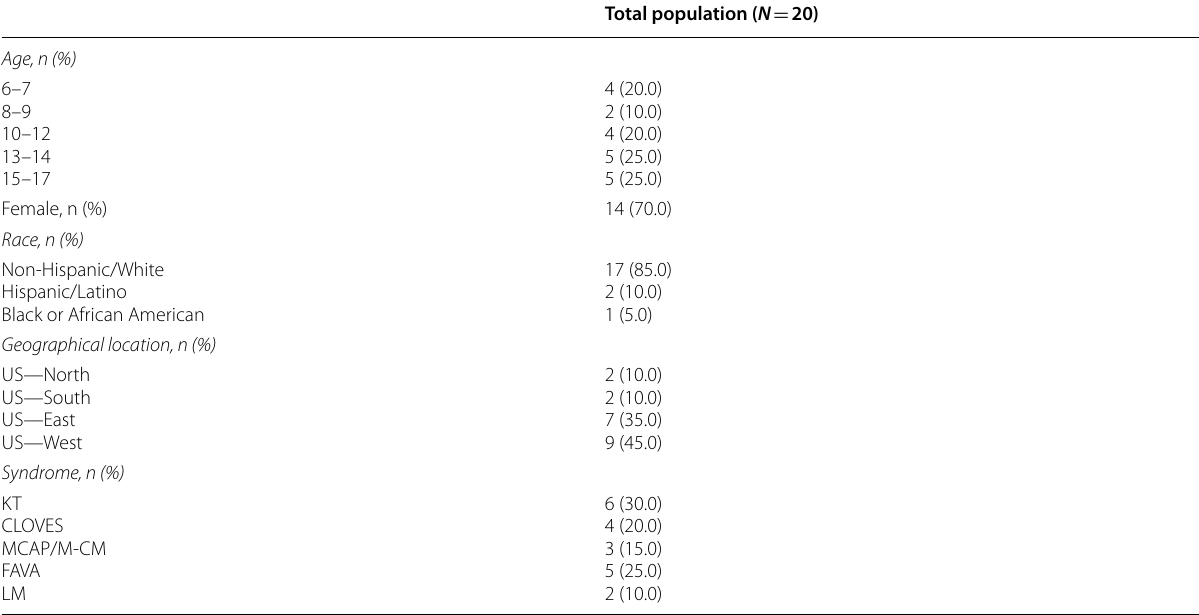
Table 4 Child (6–17 years) Participant Demographics and